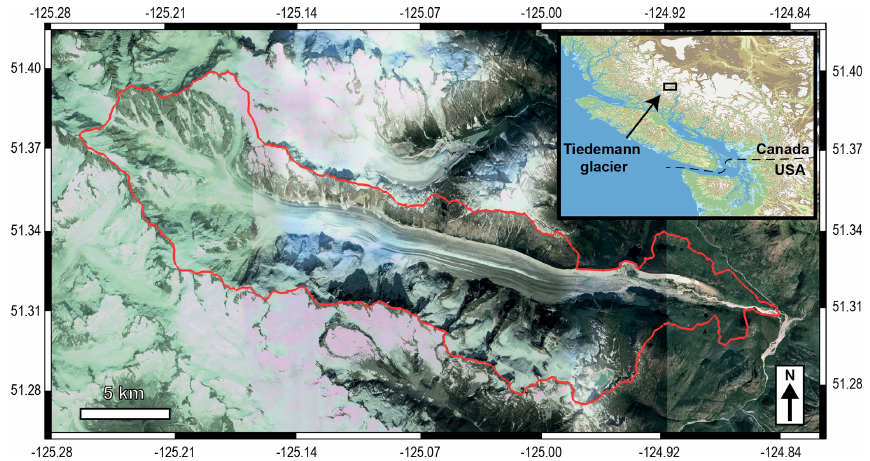
Figure 2. Satellite view of the Tiedemann Glacier, British Columbia, Canada. The red contour represents the catchment area. The inset shows the regional location in the Coast Mountains, Canada. Note the dominantly linear pattern of sediment transport (image from © Google Earth, Maxar Technologies; inset map with data from Jarvis et al.,